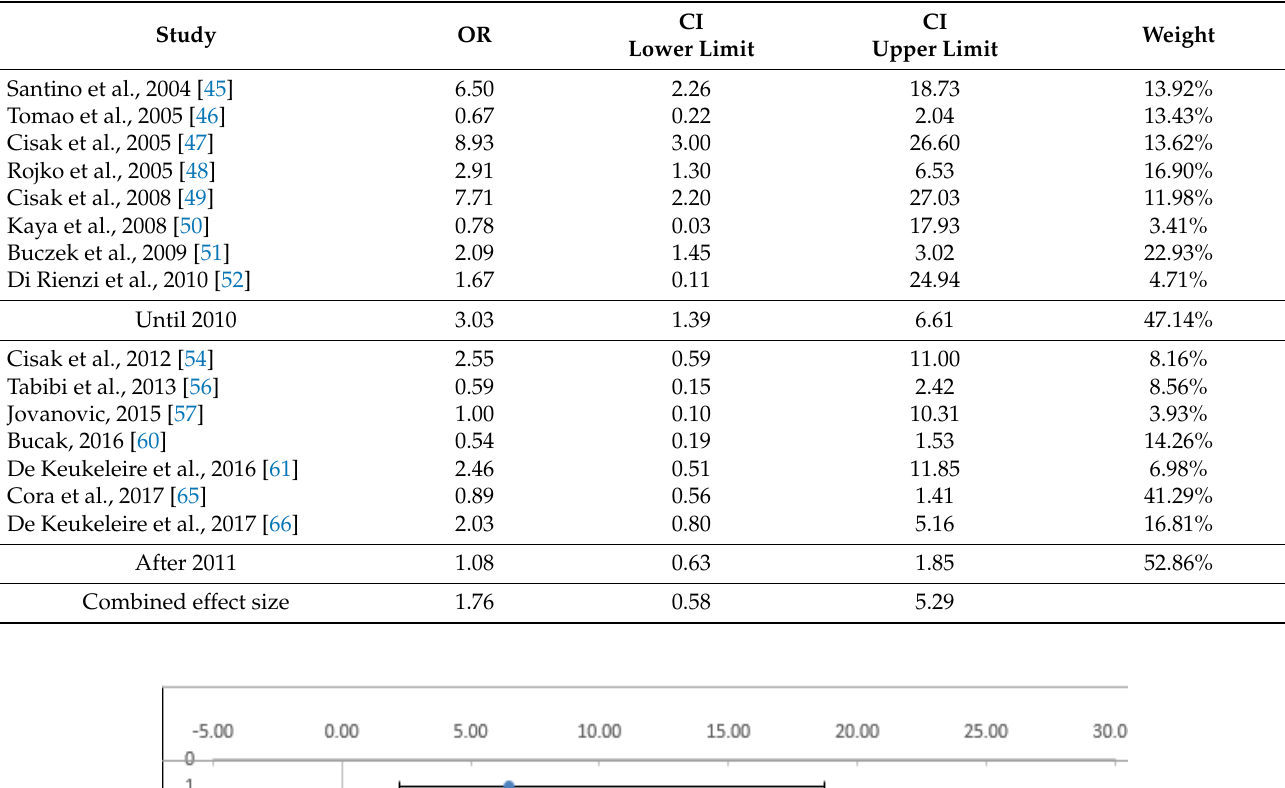
Table 4. Comparison of studies performed before and after 2011.